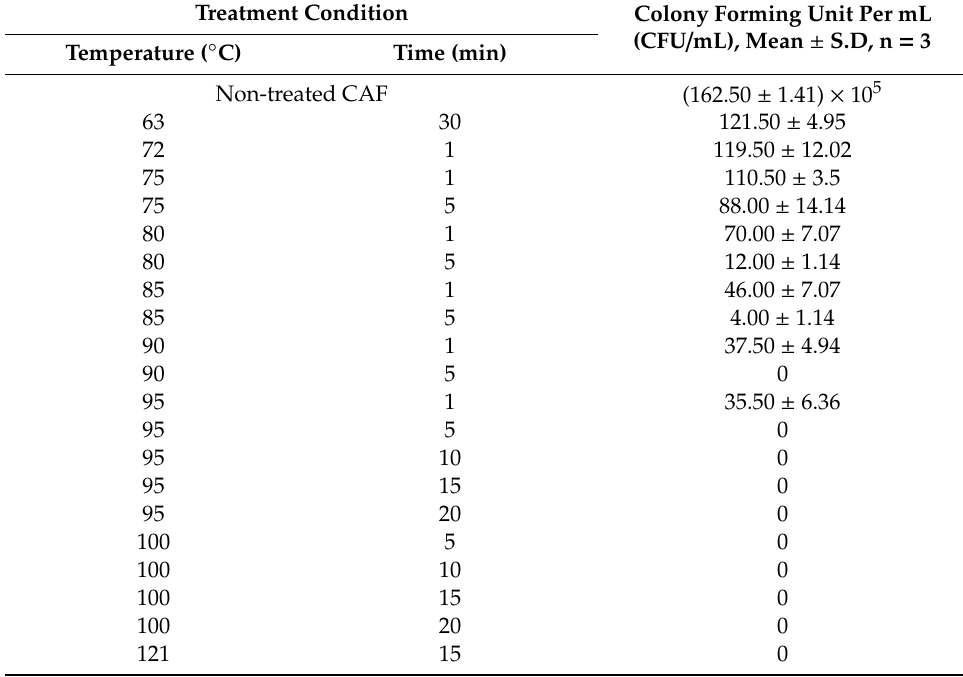
Table 2. Pasteurization test of cucumber